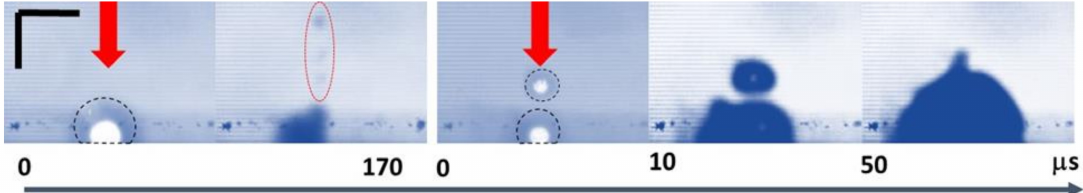
Figure 6. Optical breakdown of water on the Si by the second shot in 10 s (second red vertical arrow along the time scale) at the spatial position of the jet-expelled bubble content, duplication, and merging of the bubbles (vertical and horizontal scale bars—500 µ m).